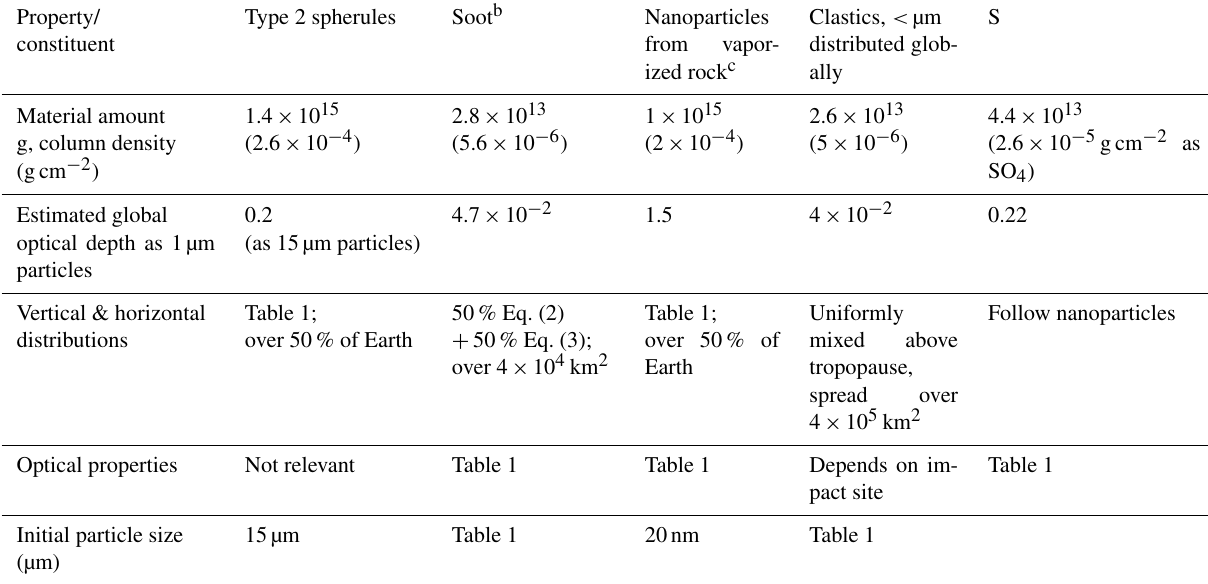
Table 3. The 1km land a injection scenario for impactor mass 1.4 × 10 15 g; impactor energy ∼ 2.8 × 10 20 J = 6.8 × 10 4 Mt.